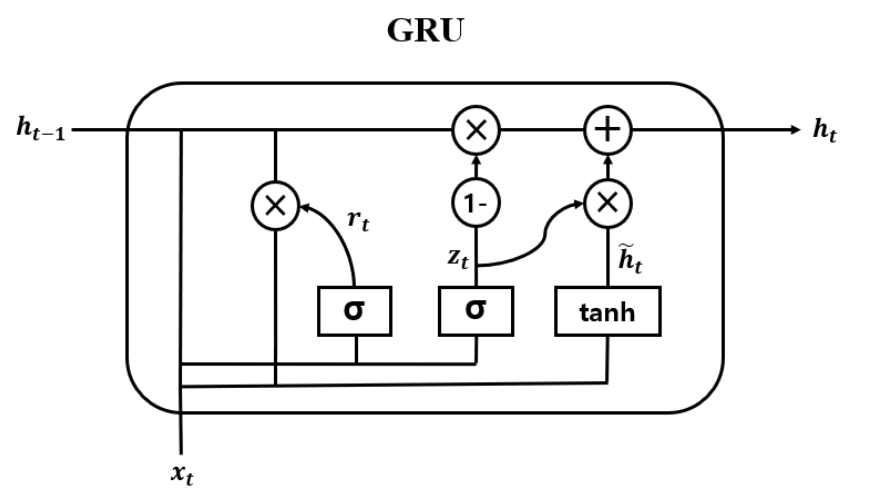
Figure 10. Internal structure of